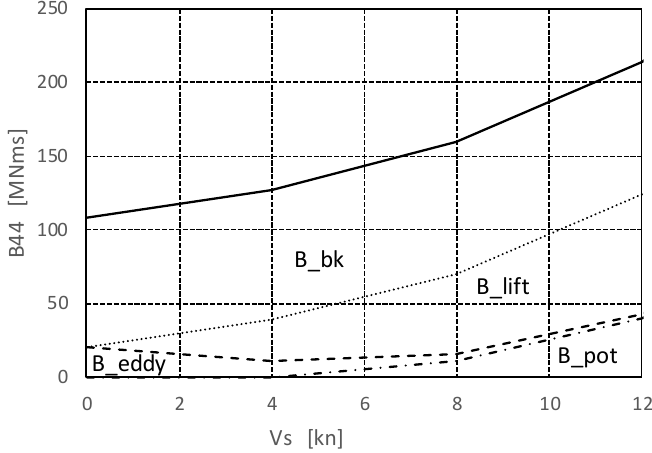
Figure 15. Roll damping contributions for the KCS, LC-1, at the natural roll period (T φ = 23.4 s) as a function of the forward speed. The figure shows the contribution of different components: Potential flow component including the effect of forward speed, the eddy damping component, the lift component and the bilge keel component. For Vs = 8 kn, the bilge keels provide 56% of the total roll damping.